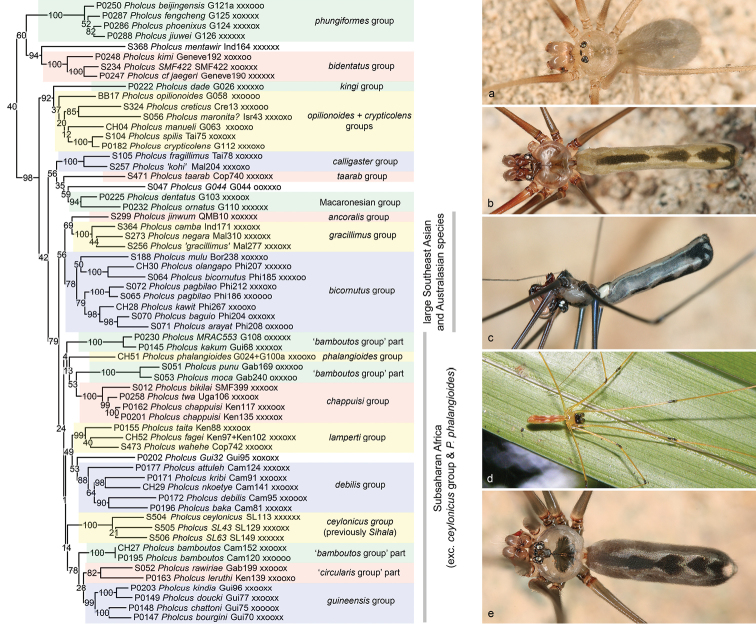
PholcusaP.creticus (Crete) bP.camba (Sulawesi) cP.mulu (Sarawak) dP.baka (Gabon) eP. sp. n. “SL43” (Sri Lanka).